Question: What form of chart is displayed?
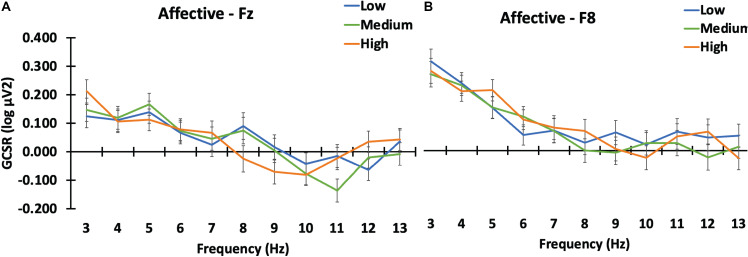
Answer: bar